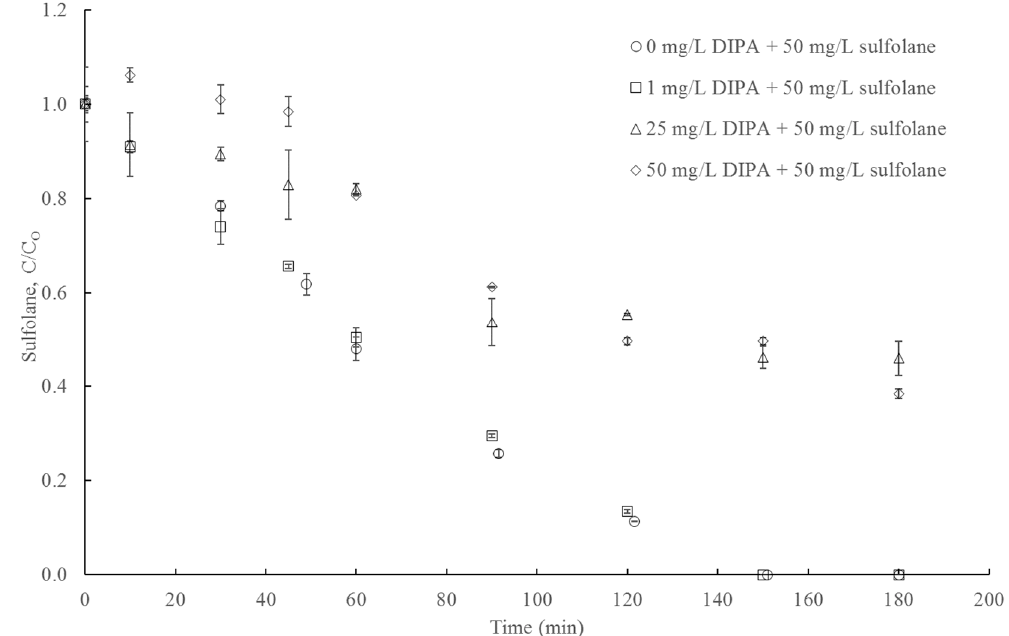
Figure 4. Photocatalytic degradation of sulfolane by TiO 2 (2 g/L) in the presence of varying concentrations of DIPA.